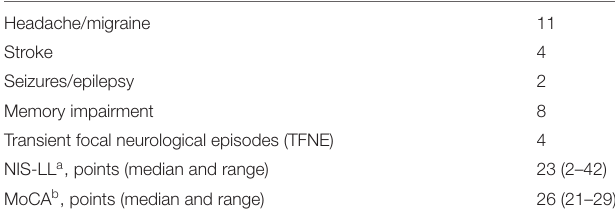
TABLE 2 | Neurological symptoms and findings. TABLE 3 | Outcome of [ 18 F]flutemetamol PET/CT